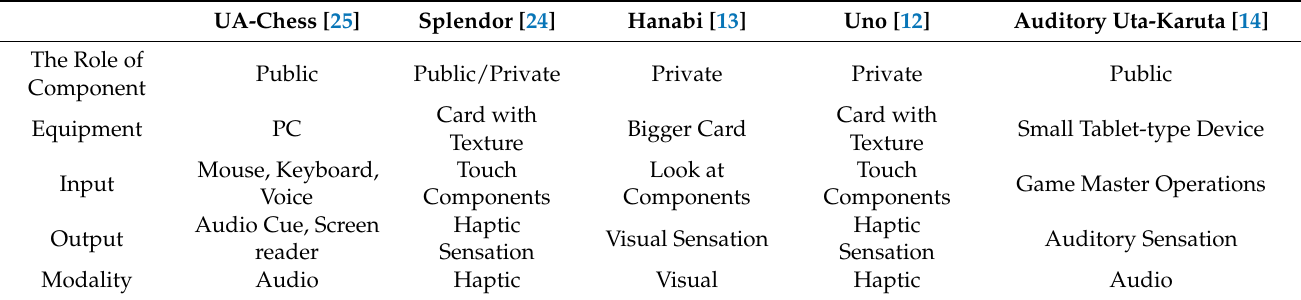
Table 1. Comparison between related works and proposal